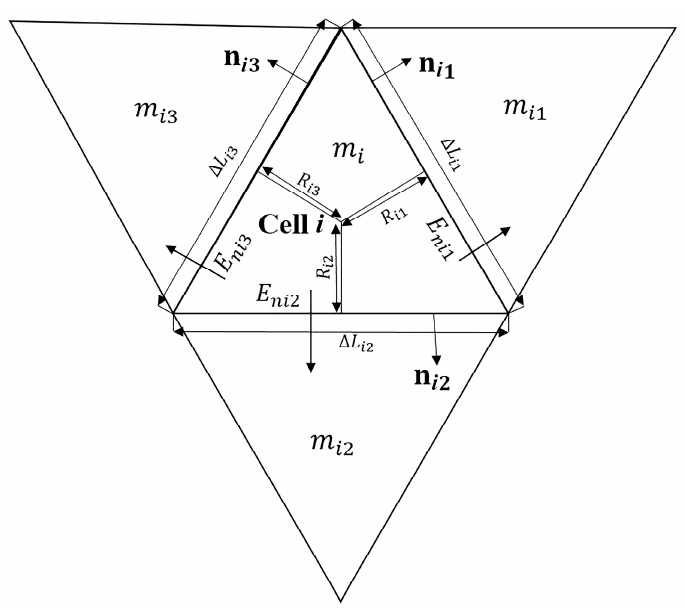
Figure 1. Sketches of the unstructured triangular meshes: a cell surrounded by three cells.